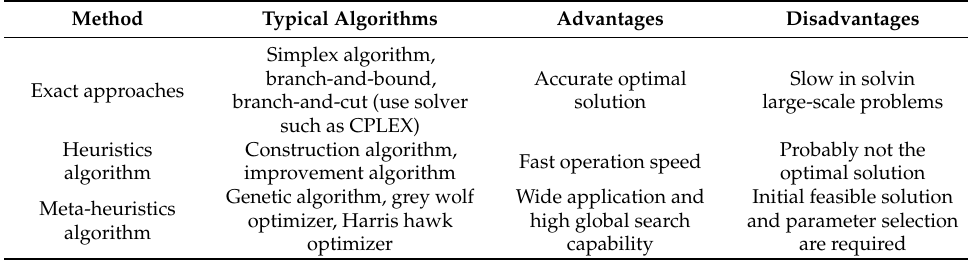
Table 3. Comparison of three types of